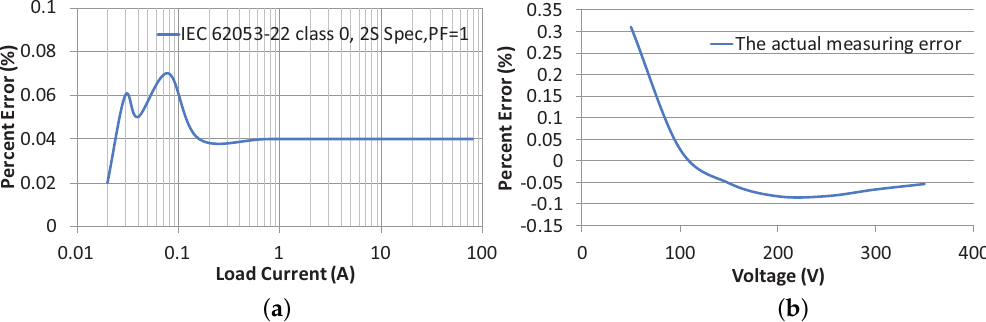
Figure 4. Measurement accuracy of energy and voltage. The figure on the left is the energy metering error ratio in the corresponding charging current, while right is the voltage measurement errors. Conditions for testing are listed as: ( a ) Energy metering error is measured according to the standards of IEC 62053-22. ( b ) Voltage error value is compared with standard high precision voltage